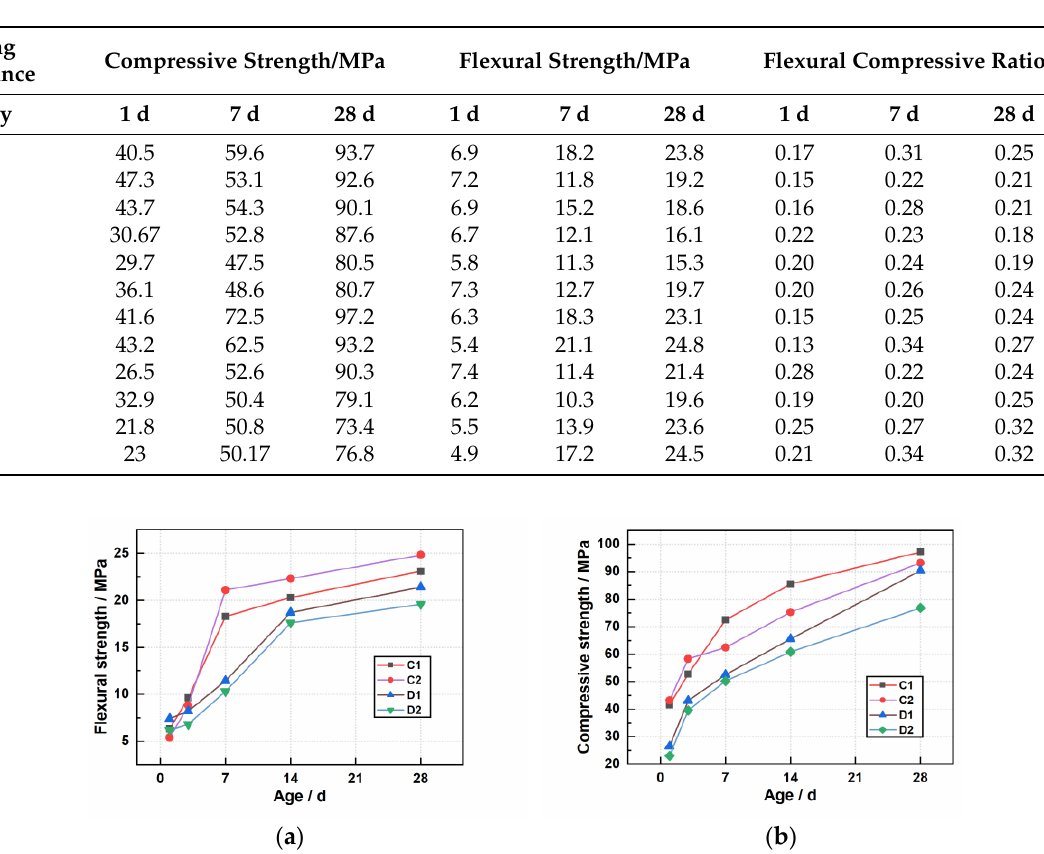
Table 9. Performance data of UHP-ECC.